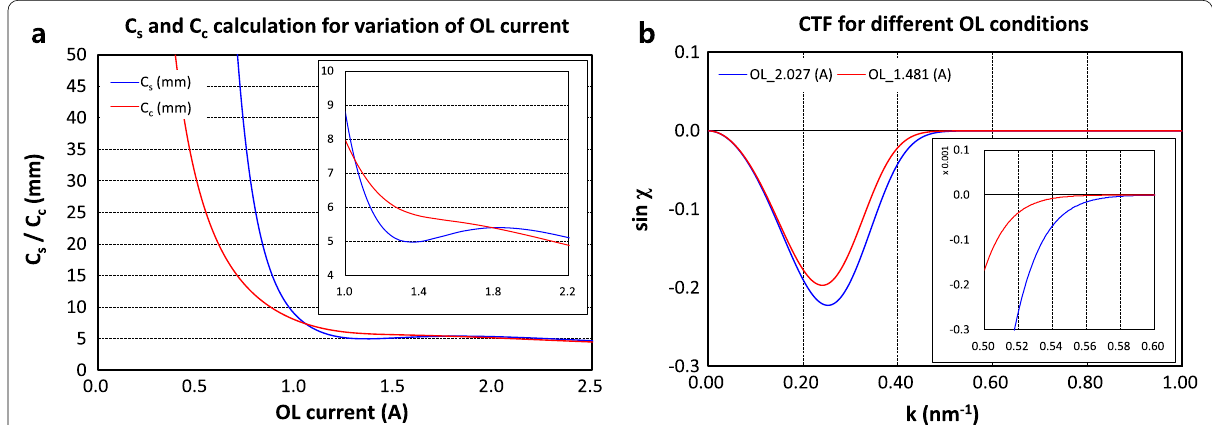
Fig. 6 a The calculation results of spherical and chromatic aberration coefficient for variation of OL current. b The CTF calculation results for two different OL conditions. Each inset in ( a ) and ( b ) represents a specific range of results for detailed